Question: Briefly state, in one sentence, what is plotted here.
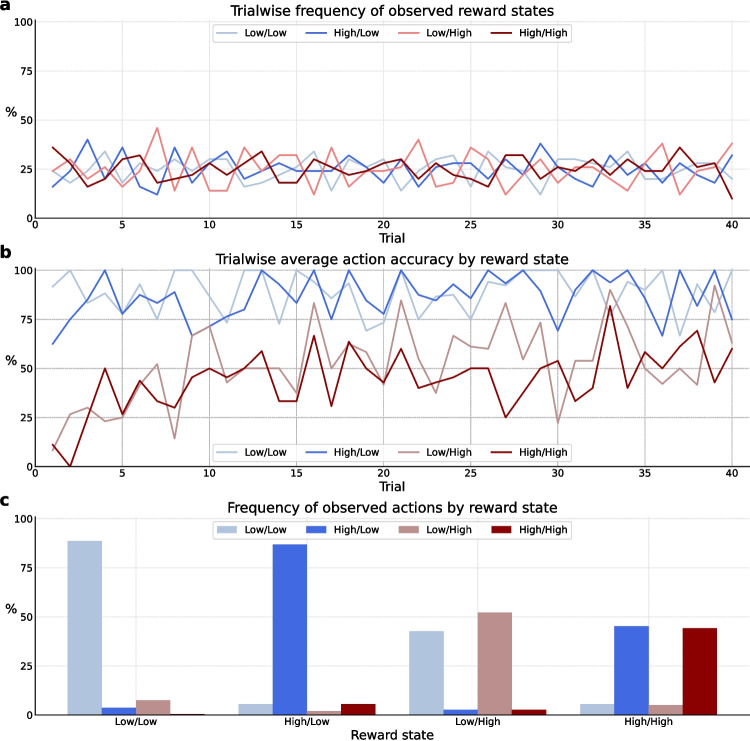
Answer: Reward state-specific evaluation of participants’ behavior. a Trialwise frequency of observed reward states. The participant-specific trial-by-trial sequence of reward states was pseudo-randomized in blocks of four trials, such that each reward state occurred once in each block and the same reward state could not be presented on two successive trials. For a given trial, the frequencies sum to 100% across observed reward states. The colors depict the reward states ( positive reward level / negative reward level ). b Trialwise average action accuracy by reward state. The colors depict the reward states ( positive reward level / negative reward level ). c Frequency of observed actions by reward state. The colored bars depict the frequency of participants’ actions for a given reward state. For a given reward state, the action frequencies sum to 100%. For the generation of this figure, please see abm_figure_3.py